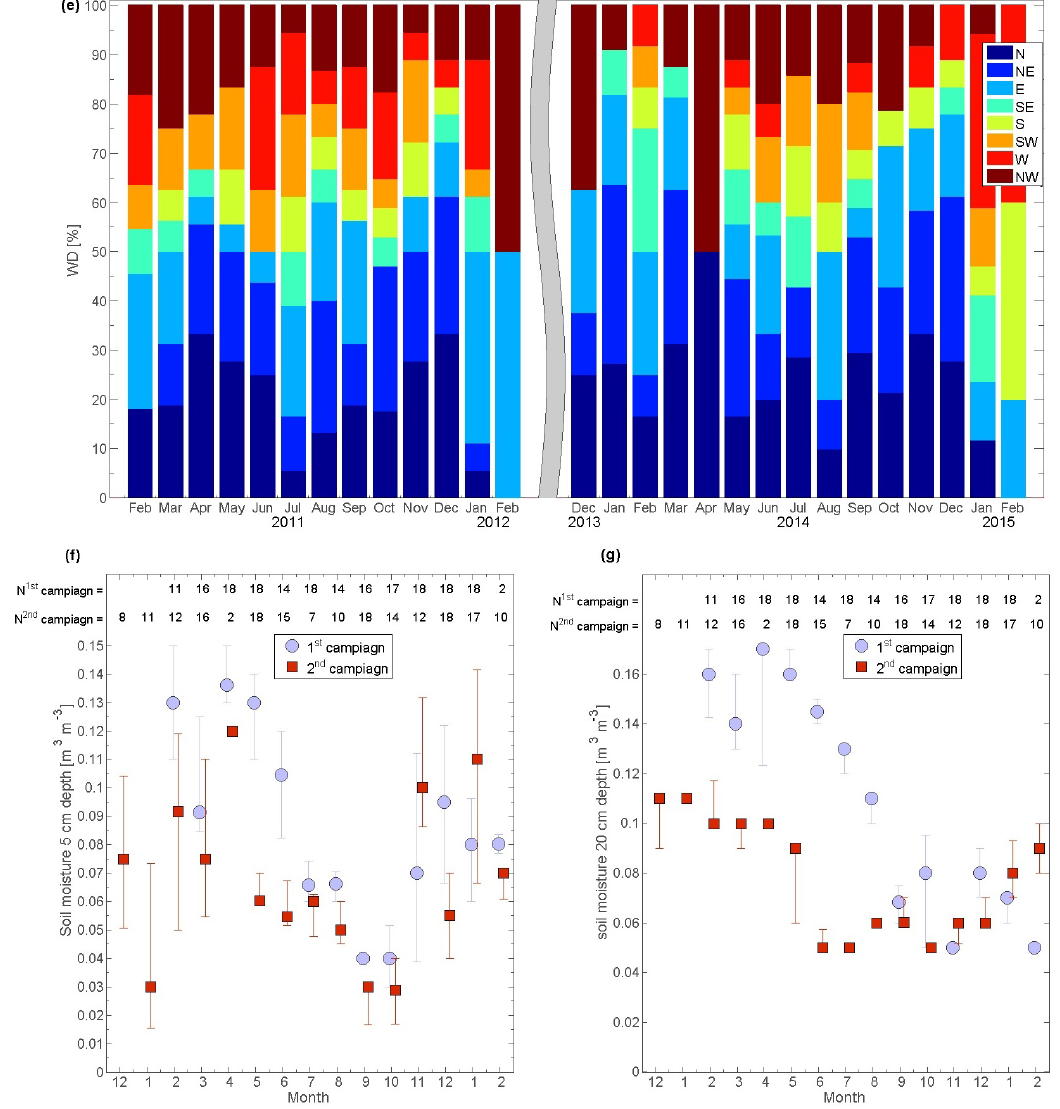
Figure 3. Monthly variation of (a) accumulated precipitation, (b) temperature, (c) relative humidity, (d) wind speed, (e) wind direction, and (f) and (g) soil moisture at 5 and 20cm depth, respectively. Error bars indicate upper and lower